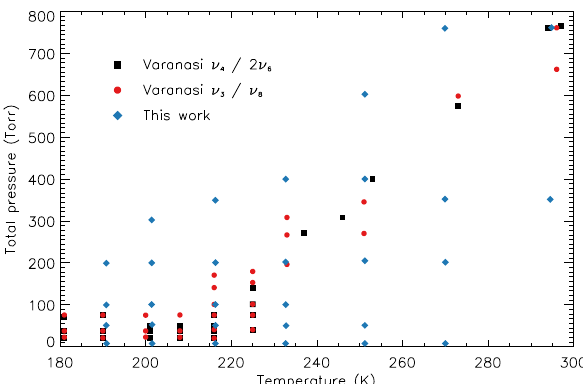
Figure 4. A graphical representation of the PT coverage for both the new and Varanasi datasets. Although the new dataset contains fewer individual IR absorption cross sections (30), it has been optimised to provide a more balanced dataset with wider PT